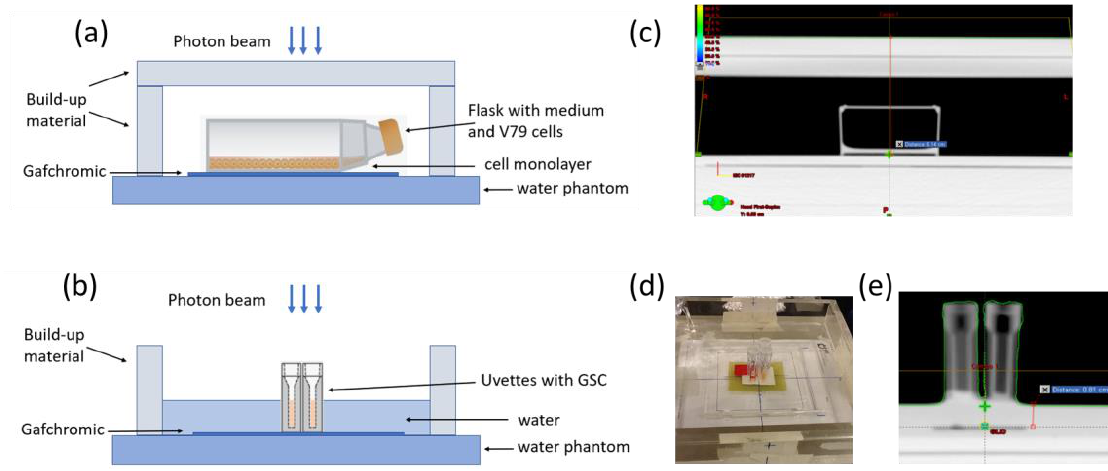
Figure 7. Experimental setup for V79 ( a , c ) and GCS cells ( b , d , e ).